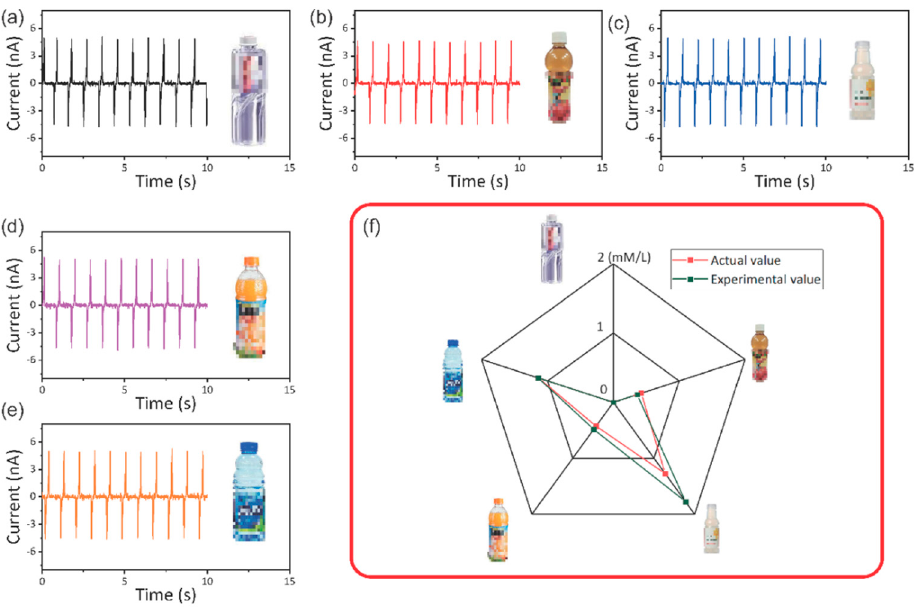
Figure 7. The practical application in detecting ascorbic acid in different drinks. ( a – e ) The output triboelectric current against mineral water, apple juice, compound juice, orange juice, and vitamin drink, respectively. ( f ) Corresponding measured response and AA concentration in these drinks.